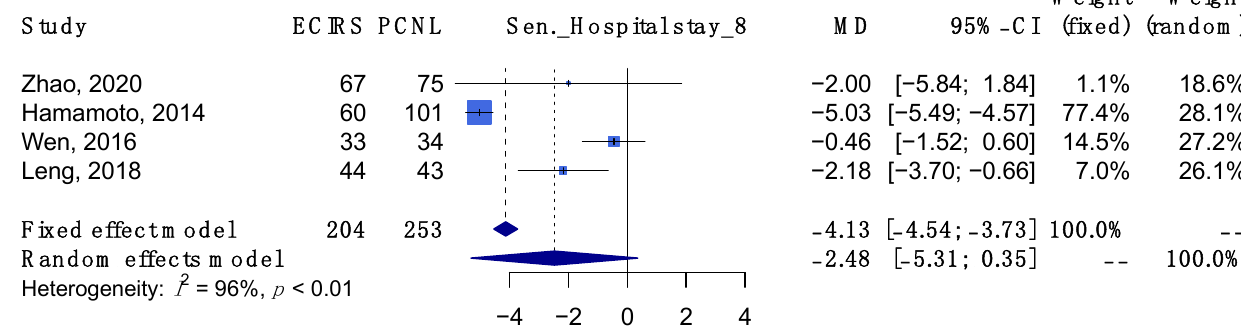
Figure A36. Sensitivity analysis of outcome regarding hospital stay. ([17–19,22]).